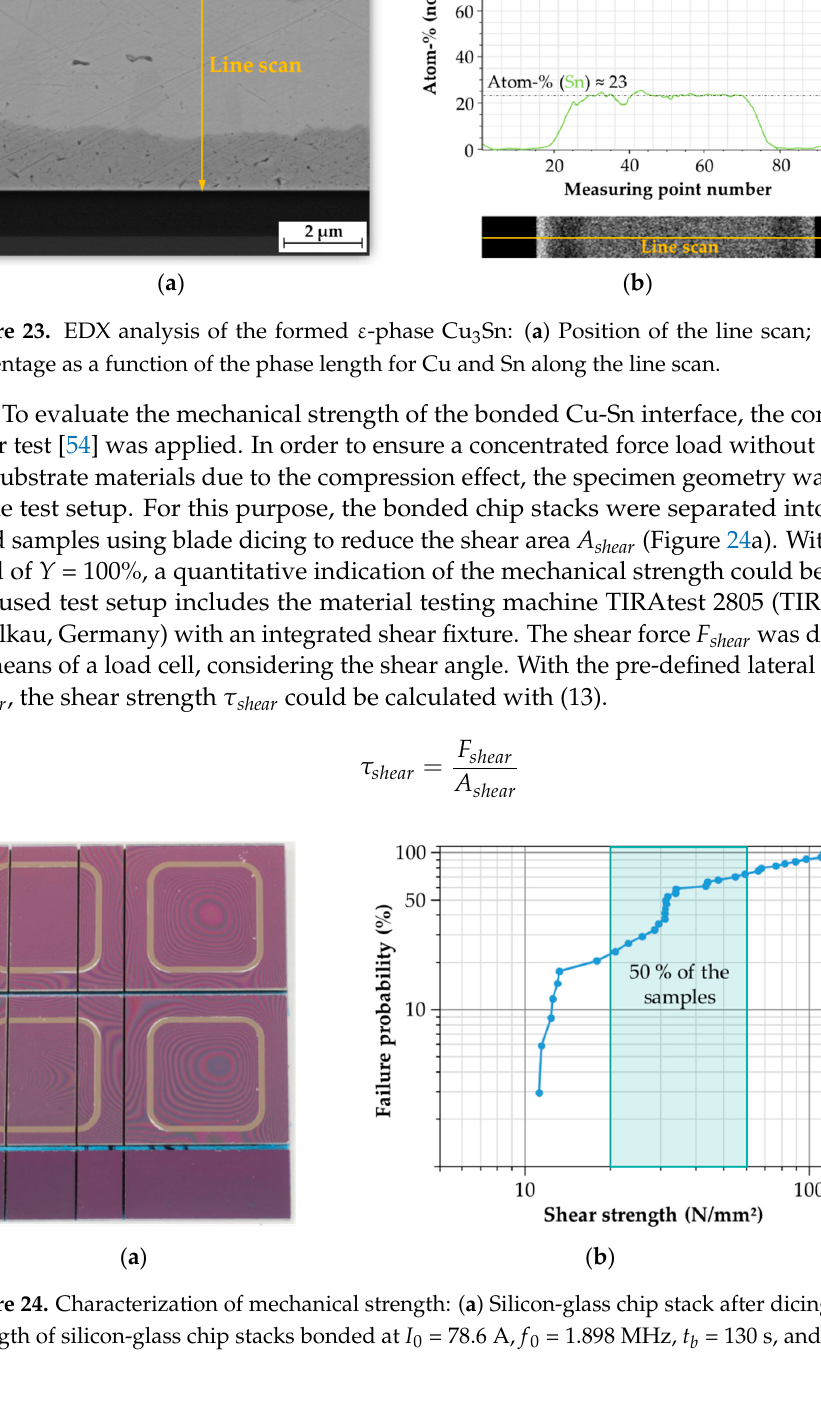
Figure 22. Inductive Cu-Sn SLID bonding for I 0 = 78.6 A and f 0 = 1.898 MHz: ( a ) Silicon-glass chip